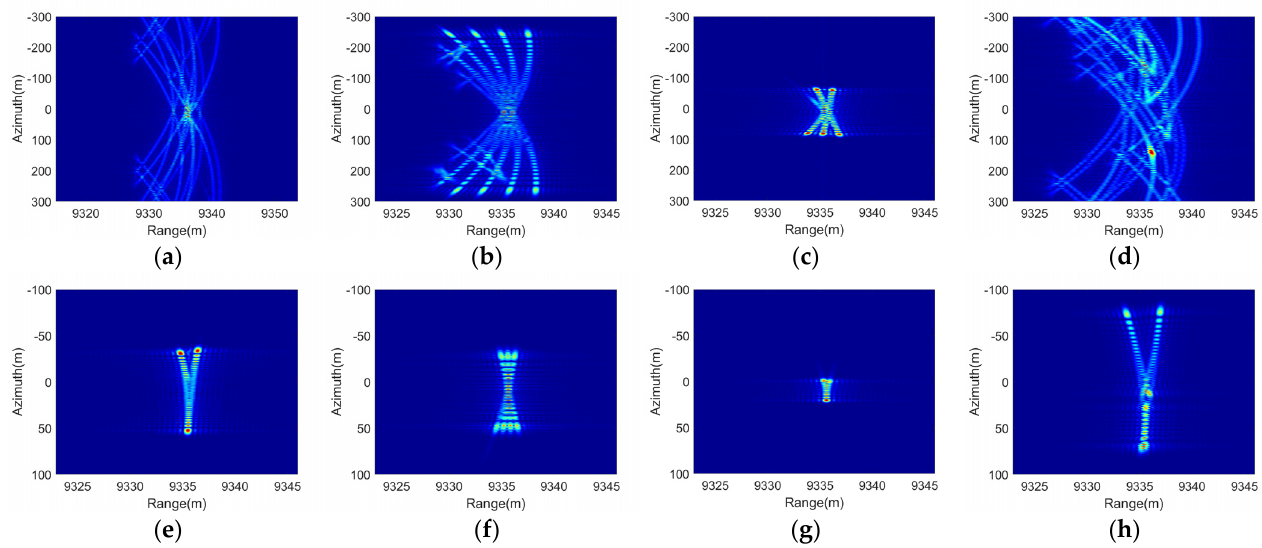
Figure 18. Focusing results of the point target with angular oscillations of two ships on sea-state 5. ( a ) Destroyer, roll motion; ( b ) destroyer, pitch motion; ( c ) destroyer, yaw motion; ( d ) destroyer, all the three angular oscillations; ( e ) carrier, roll motion; ( f ) carrier, pitch motion; ( g ) carrier, yaw motion; ( h ) carrier, all the three angular oscillations.